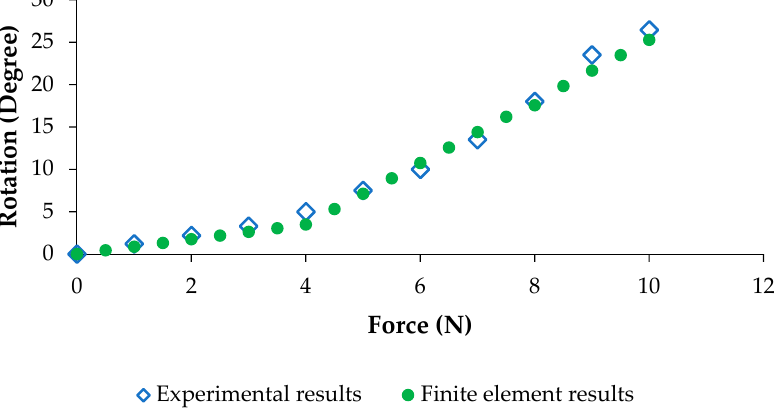
Figure 18. Model validation: a comparison between experimental data with FE model data.